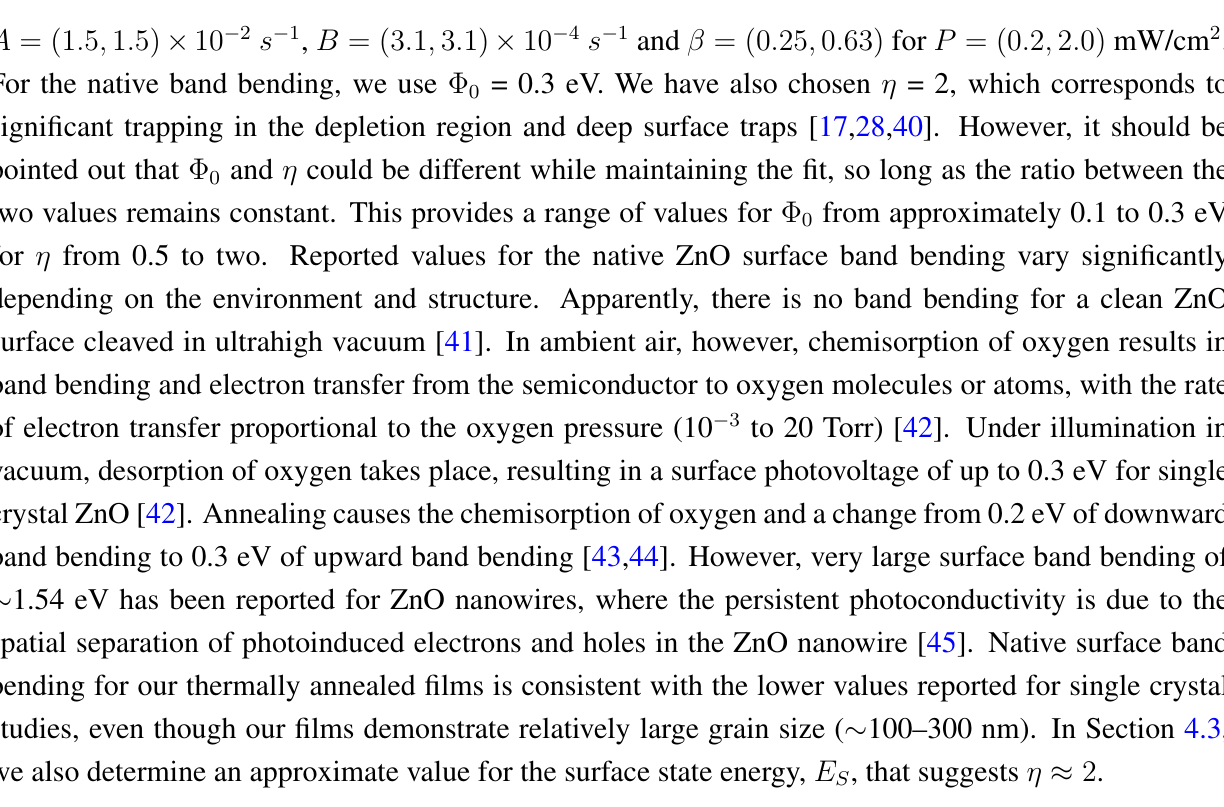
Photocurrent transient relaxation at room temperature ( T = 293 K) with op increasing illumination intensity measured at P = 0.2 mW/cm 2 and P = 2.0 mW/cm 2 (filled circles). Experimental data is fit to Equation (11), with the best fit shown as the solid lines. For P = (0 . 2 , 2 . 0) mW/cm 2 , coefficients of best fit are A = (1 . 5 , 1 . 5) × 10 − 2 s − 1 , B = (3 . 1 , 3 . 1) × 10 − 4 s − 1 and β = (0 . 25 , 0 . 63) . ( η = 2, Φ = 0.3 eV). The base film 0